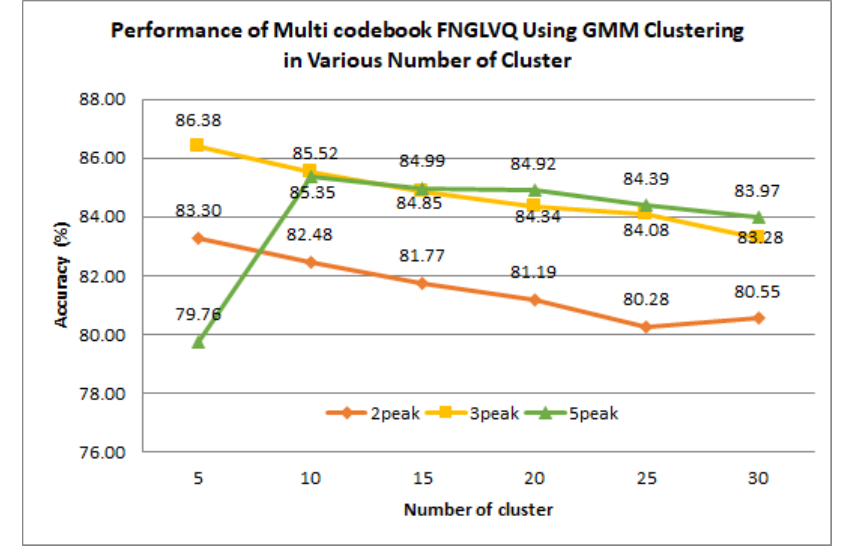
Figure 7. The impact of number of cluster on GMM